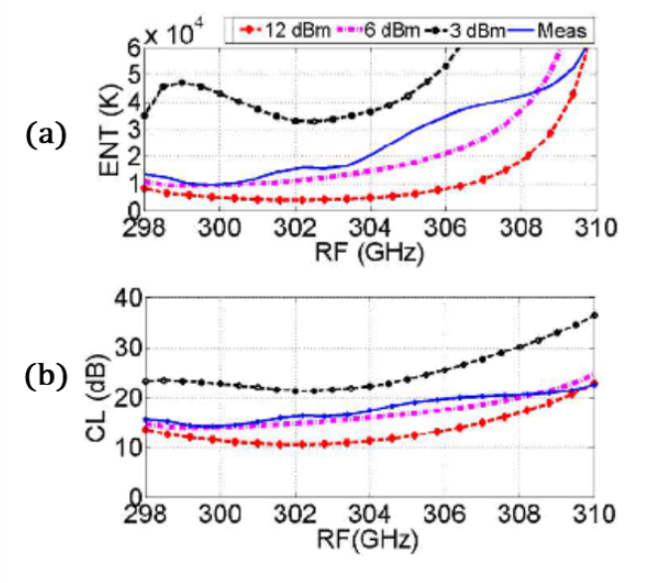
Figure 3. Comparison between the experimental performance of the fourth-harmonic mixer for an intermediate frequency, IF = 2 GHz, and its simulated performance for various LO powers. ( a ) DSB equivalent noise temperature and ( b ) conversion